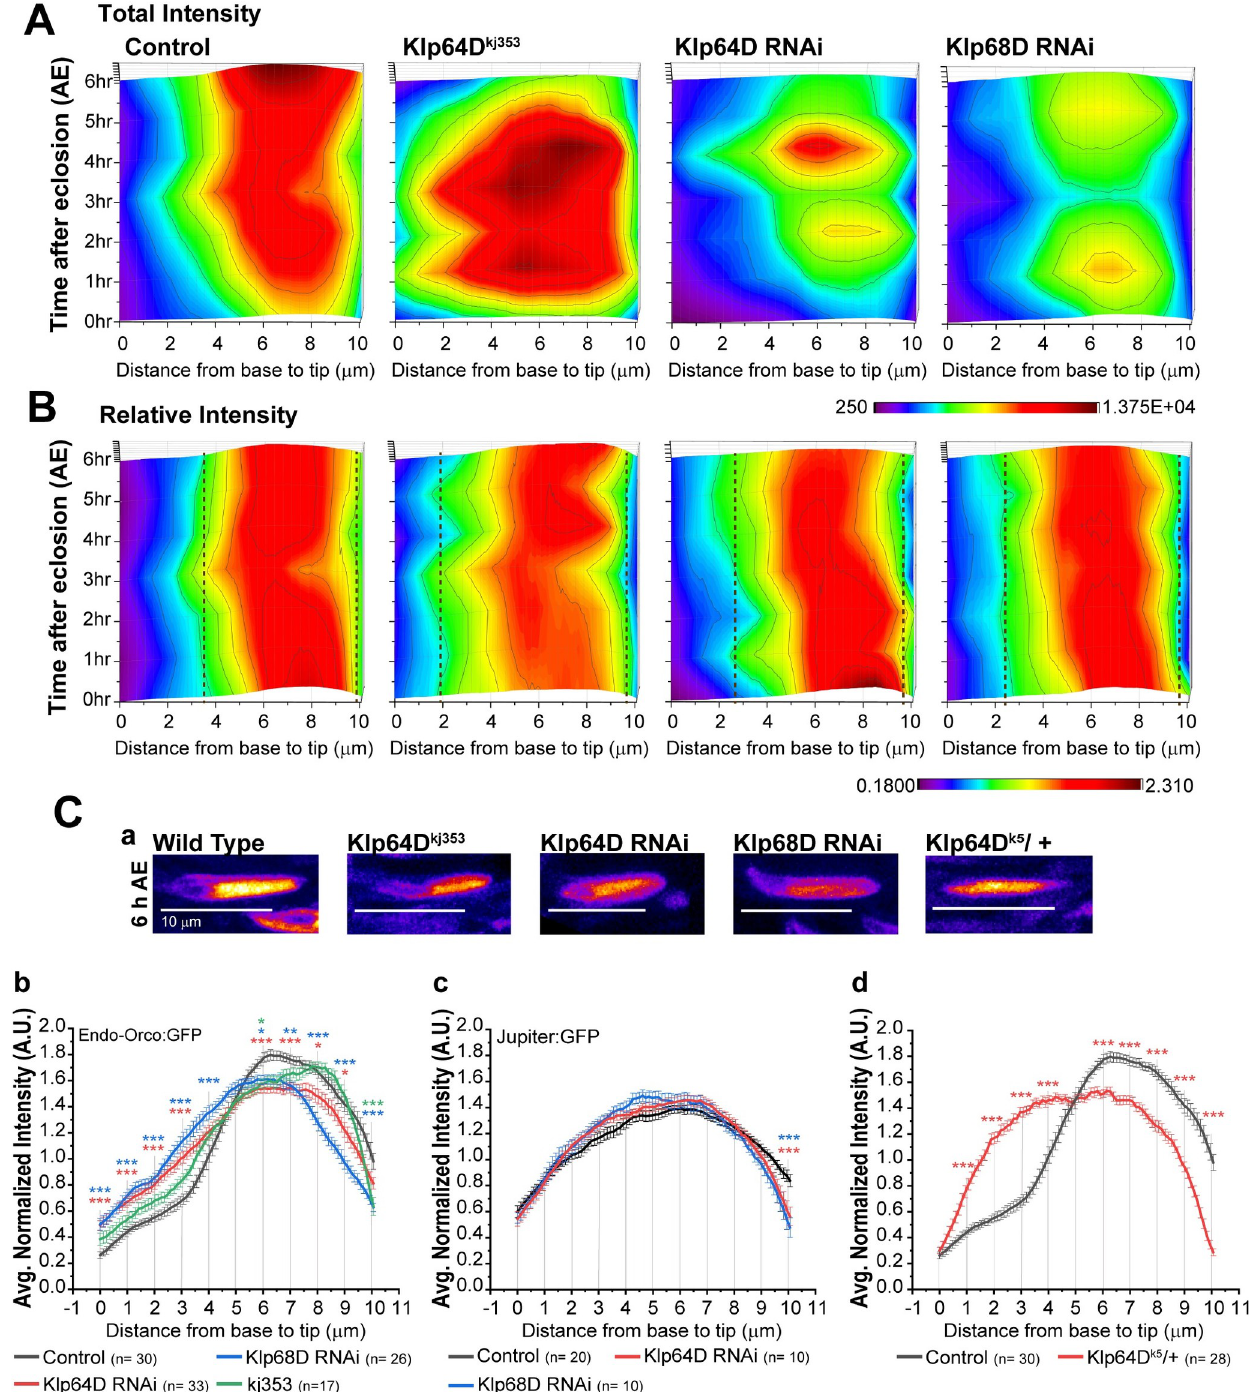
Fig 8. Endo-Orco:GFP distribution in the kinesin-2 mutant and RNAi backgrounds. (A-B) Surface plots for total (A) and normalised intensity (B) distributions of Endo-Orco:GFP along the ciliary OS during 0–6 hours AE in the wild-type control, homozygous Klp64D kj353 mutant, as well as Klp64D and Klp68D RNAi backgrounds. Dotted lines demarcate the full-width-at-half-maxima (FWHMs) of the Endo-Orco:GFP localisation domains. Note that FWHMs in the mutant backgrounds expands beyond the wild-type domain boundary (4 μ m position). (C) Images of Endo-Orco:GFP location in the cilia inside ab1-type sensilla from different genetic backgrounds are shown in the false colour heat map (FIRE, ImageJ) with scale bars indicating 10 μ m (a). Plot profiles indicates the Endo-Orco:GFP (b and d) and Jupiter:GFP (c) distribution (mean ± S.E.M.) along the ciliary OS at 6 hours AE in different genetic backgrounds. The pairwise significance of difference was estimated using one-way ANOVA test, p-values ( � p < 0.05, �� p < 0.01, and ��� p < 0.001) are shown on the plots. Number of sensillae (n) quantified is indicated on the panels. https://doi.org/10.1371/journal.pgen.1009752.g008 PLOS Genetics | https://doi.org/10.1371/journal.pgen.1009752 August 19,